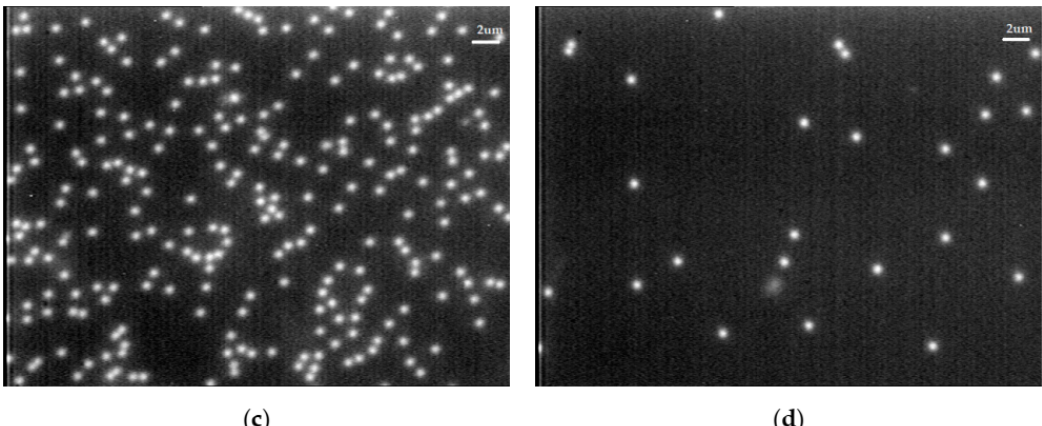
Figure 7. Micrographs of particle layers on top of HSA layers on mica acquired by optical microscopy under wet conditions, dark field illumination. ( a ) particle coverage 0.52, HSA surface concentration N = 2 × 10 3 µ m − 2 , ( b )particle coverage 0.20, HSA surface concentration N = 7.5 × 10 2 µ m − 2 , ( c ) particle coverage 0.08, HSA surface concentration N = 6 × 10 2 µ m − 2 , and ( d ) particle coverage 0.02, HSA surface concentration N = 4 × 10 2 µ m − 2